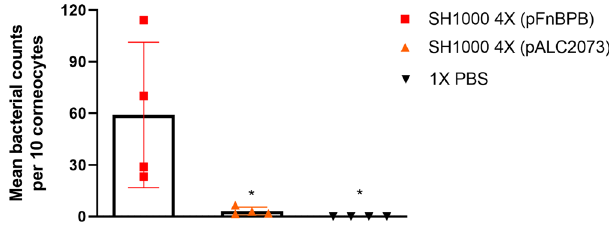
Fig. 5 S. aureus adherence to healthy human corneocytes is mediated by FnBPB. SH1000 de fi cient in ClfA, ClfB, FnBPA, and FnBPB [SH1000 4X] carrying pALC2073:: fnbB (pFnBPB) and pALC2073 were grown to exponential phase (OD 600 = 0.35), incubated with healthy human corneocytes at 37 °C, washed, and adherent bacteria were stained with crystal violet. Corneocytes were visualised using light microscopy and the number of bacteria adhering to ten corneocytes was counted. Each datum point represents the mean number of bacteria per corneocyte. The bars represent the means of four independent experiments, with error bars showing the standard deviation. A no bacteria control was used where PBS alone was incubated with the corneocytes. Statistical analysis was performed using a one-way ANOVA with a Dunnett´s multiple comparison test to compare variances between S. aureus SH1000 4X (pFnBPB), S. aureus SH1000 4X (pALC2073), and the no bacteria control. *SH1000 4X